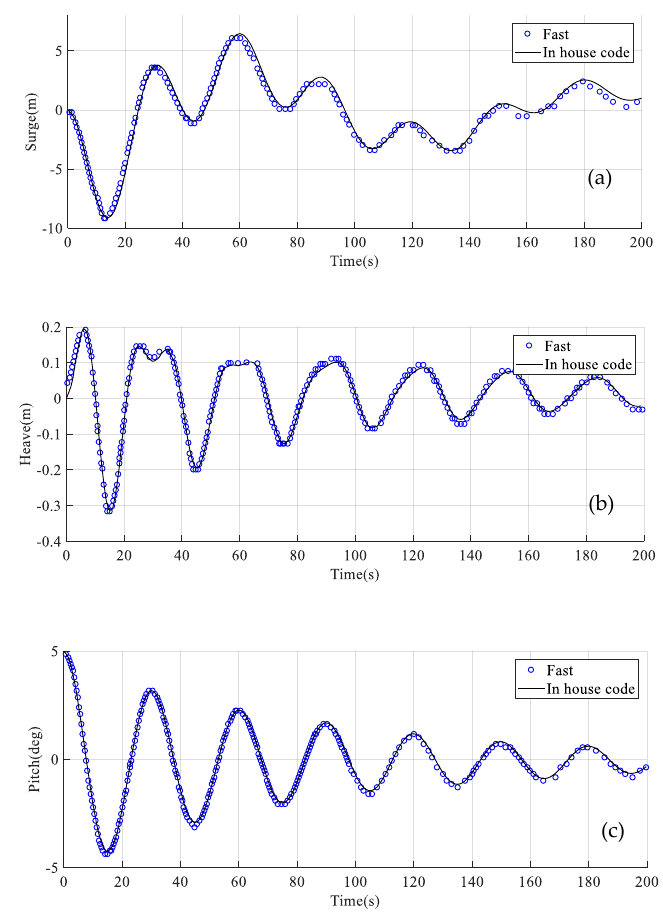
Figure 4. Dynamic response of the original OC3 model under the free decay condition calculated by the in-house developed code and FAST: ( a ) surge, ( b ) heave, and ( c )